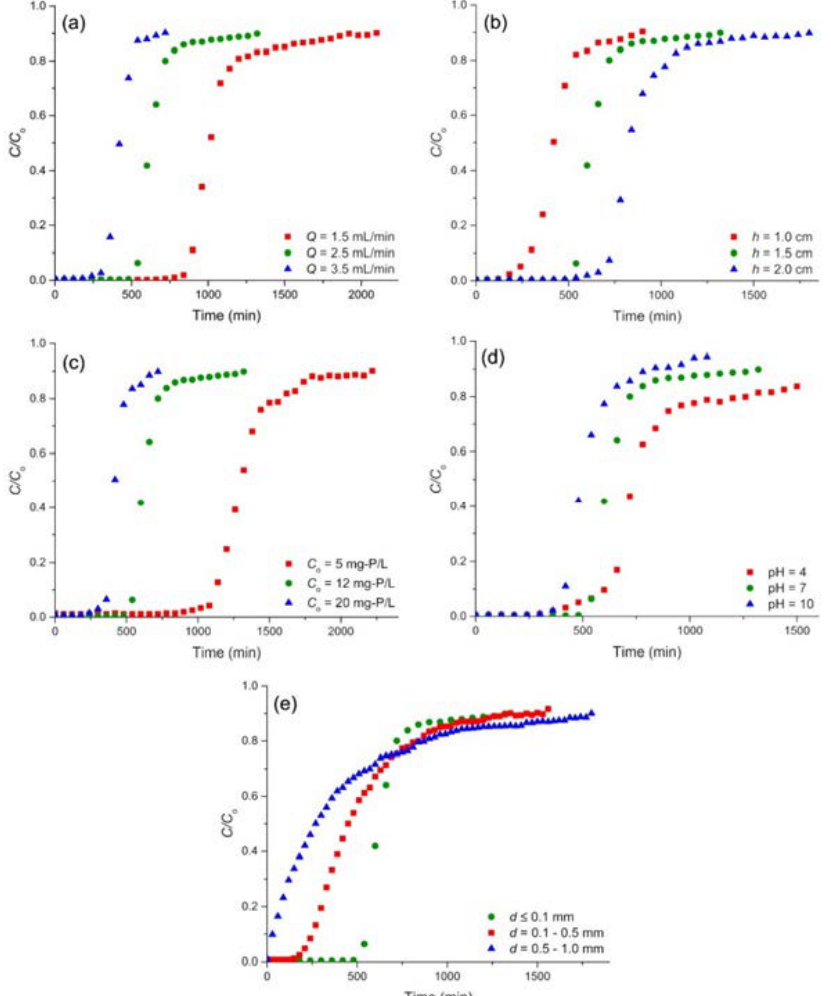
Fig. 2: The Effect of (a) flow rate ( h = 1.5 cm, C = 12 mg-P/L, pH = 7, and d ≤ 0.1 mm), (b) bed height ( Q = 2.5 mL/min, C o = 12 mg‐P/L, pH = 7, and d ≤ 0.1 mm), (c) influent phosphate concentration ( h = 1.5 cm, Q = 2.5 mL/min, pH = 7, and d ≤ 0.1 mm), (d) solution pH ( h = 1.5 cm, Q = 2.5 mL/min, C = 12 mg-P/L, and d ≤ 0.1 mm), and (e) composite particle size ( m = 1.01 g cm, Q = 2.5 mL/min, C o = 12 mg‐P/L, 7), on the fixed-bed column